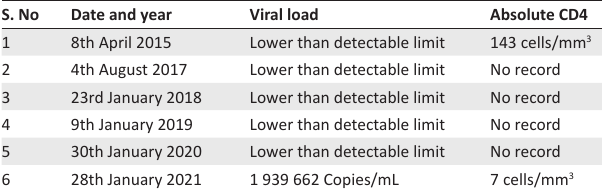
TABLE 1: Laboratory results of viral load between 2015 and